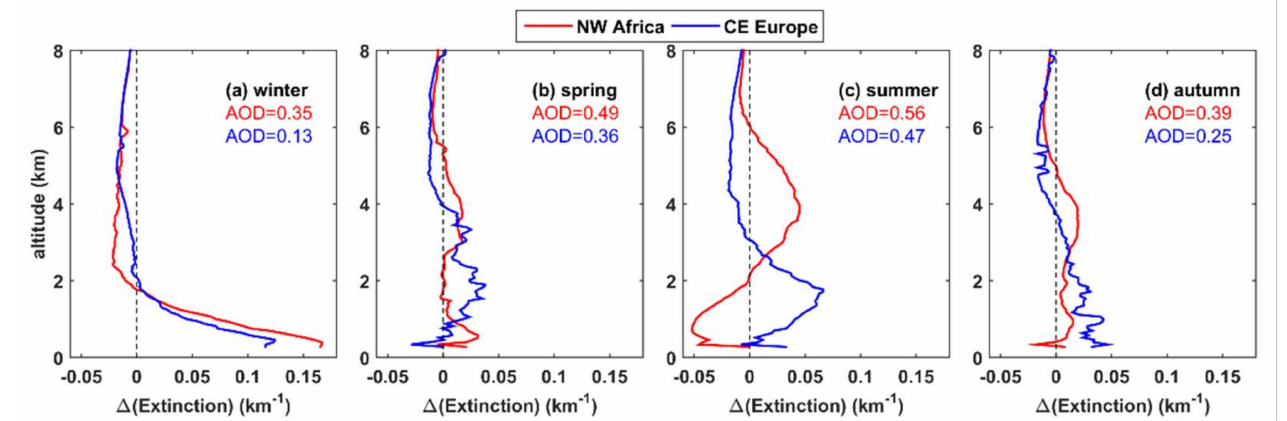
Figure 8. Differences between the LIVAS and the libRadtran default extinction coefficient profiles for the AOD at 350 nm. The results are shown for CE Europe (blue line) and NW Africa (red line) for the four seasons of the year. The 350 nm AOD for each is also shown in the panels with the corresponding colors.